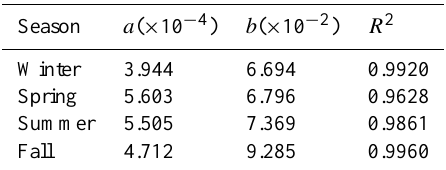
Table 4. Coefficients of the gamma parameterization written as d p − b . R 2 is the determination coefficient between the γ = − a 1nm γ obtained from GF measurements and the corresponding parame- terized